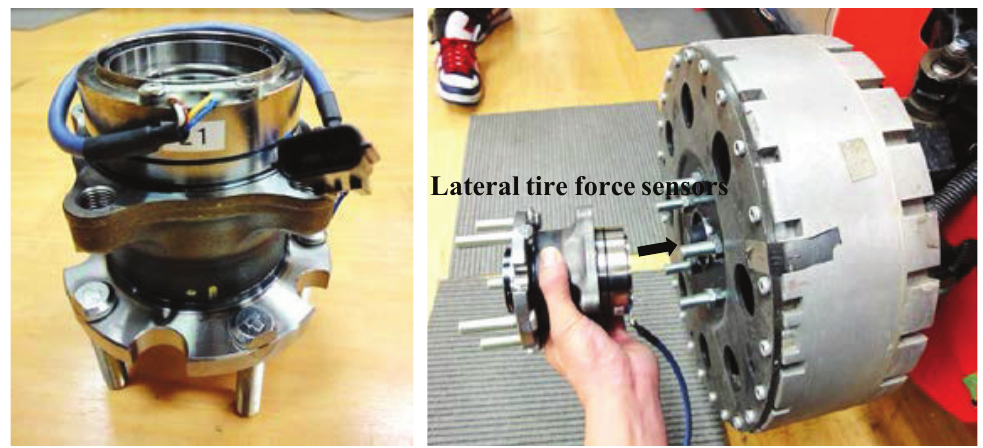
Figure 1. Real view of the lateral tire force sensor ( i.e. , force-sensing hub bearing